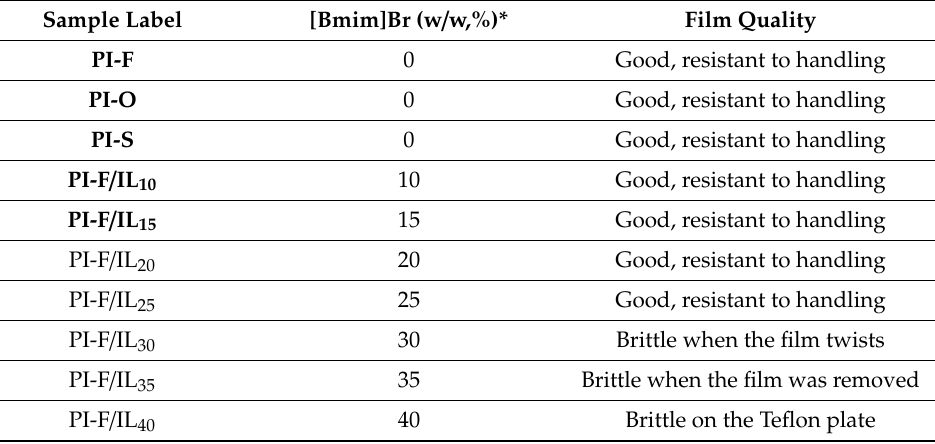
Table 3. [Bmim]Br proportion in PI-F / IL composite films and their mechanical characteristic. Sample